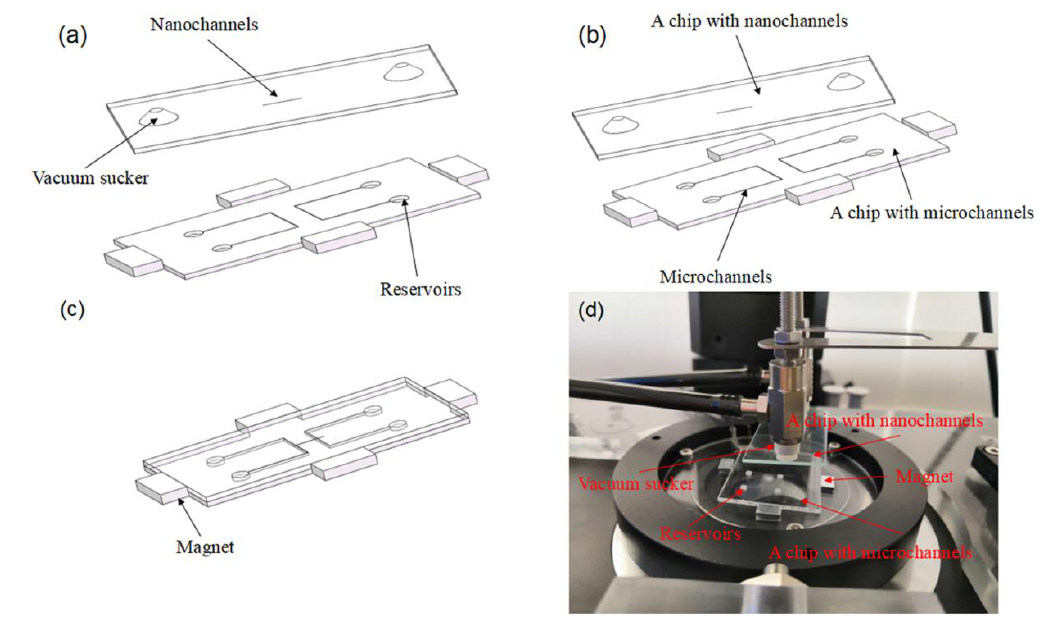
Figure 2. The assembly process for the micro/nanochannels. ( a ) The chip with the microchannels is fixed through utilizing four pairs of magnets, and the chip with the nanochannels is adsorbed through the vacuum sucker. Four reservoirs are employed to fill the solution into the channel. ( b ) An angle position of the micro/nanochannels is insured by means of regulating a screw’s micrometer connecting to micromotion component with manual rotation. ( c ) The position for x , y , and z axes is viewed based on the imaging system of the inverted fluorescence microscope via regulating a screw’s micrometer of a 3D linear stage. ( d ) The real images of the set up.